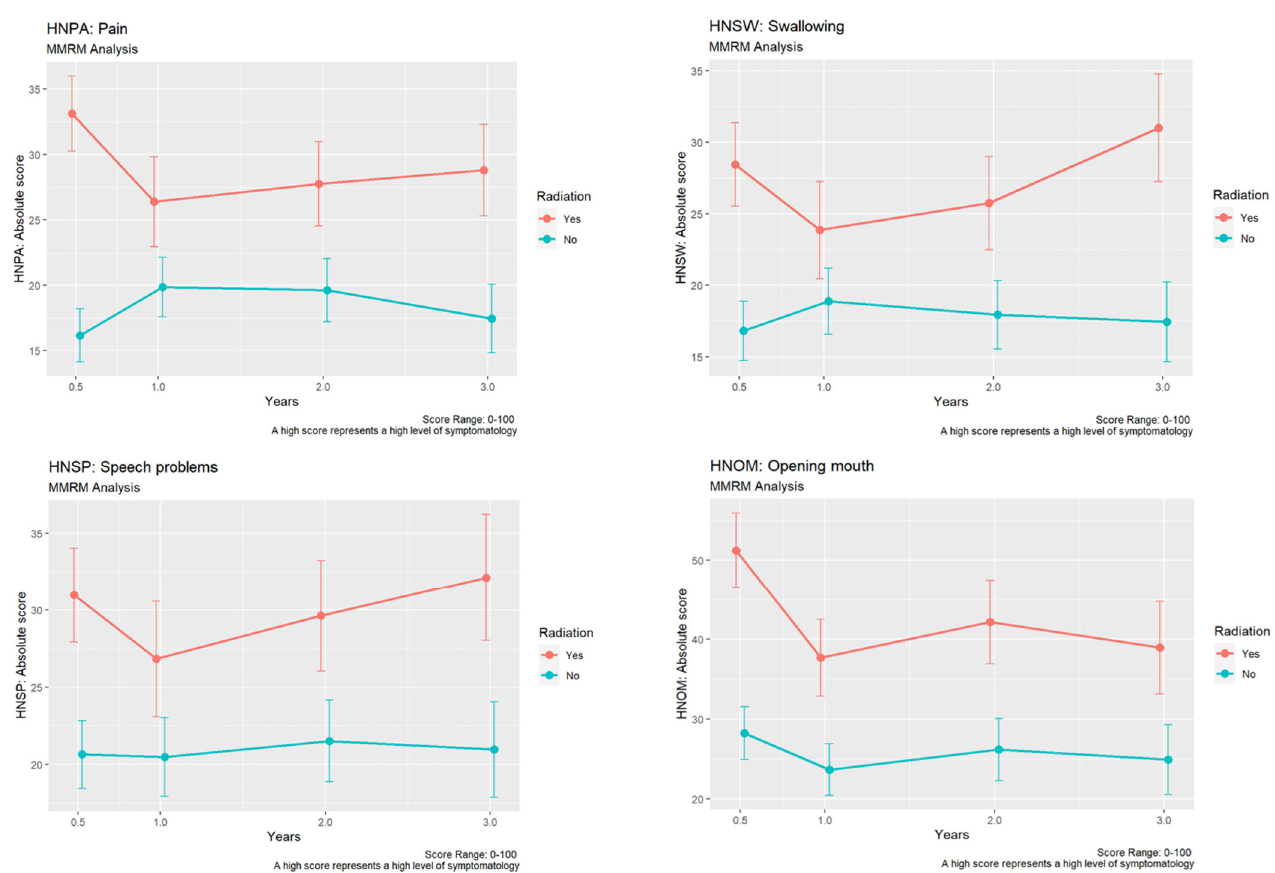
Figure 4. Development of di ff erences in “pain”, “swallowing”, “speech problems”, and “opening mouth” using EORTC QLQ-C30 H&N 35 module between the non-irradiated and the irradiated group.